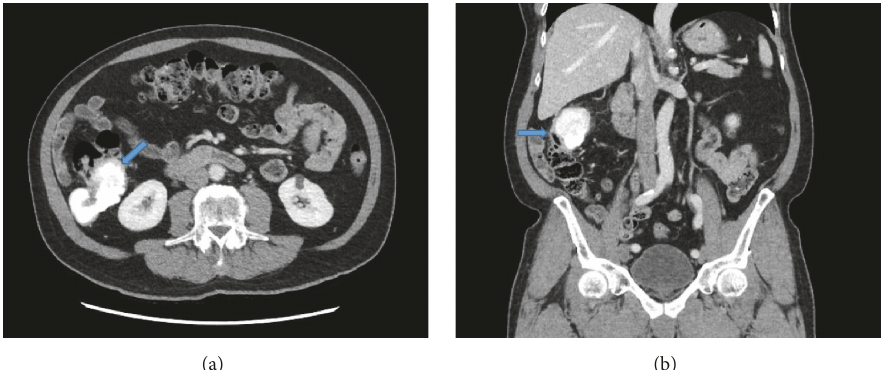
Figure 1: Contrast-enhanced CT scan images of right pericolonic mass: (a) axial and (b) coronal images demonstrate large partly exophytic lobulated mass (blue arrow) arising from the mid ascending colon with heterogeneously enhancement, consistent with mineralization or calcifications.